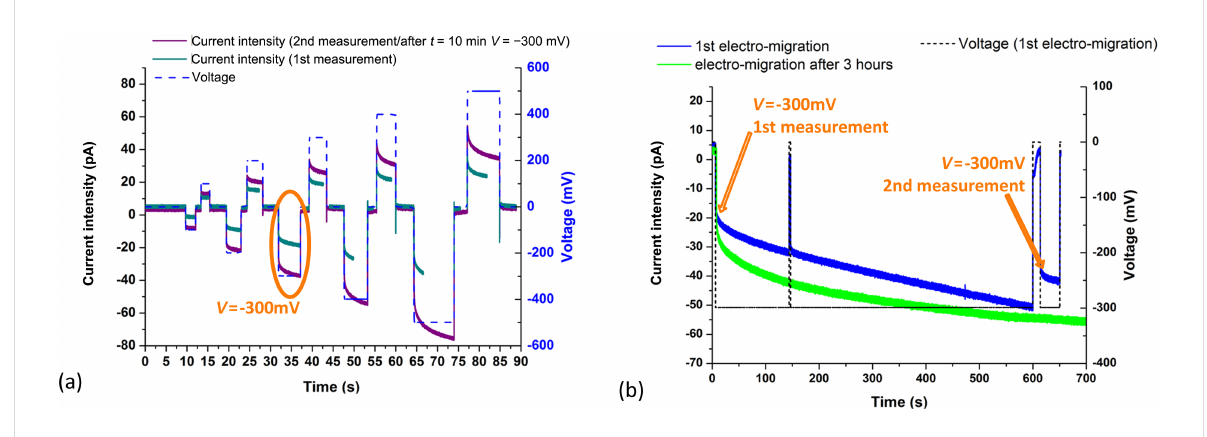
Figure 2: Typical I ( V ) measurements with pClamp: I and V are recorded as a function of the time. [KCl] = 10 − 4 mol·L − 1 and the geometrical nano- pipette characteristics are r tip = 13 nm, θ = 9° and l tip = 15 mm. (a) The first measurement (cyan) directly after the KCl filling shows the electrical conductivity of the system. The nanopipette is open and filled. The second measurement (purple) after the electromigration shown in (b) shows the nominal current intensity values together with the voltage values. The electrical characteristics are reproducible; (b) Electromigration directly after filling and three hours later, V = − 300 mV over a period of time of t = 10 min.